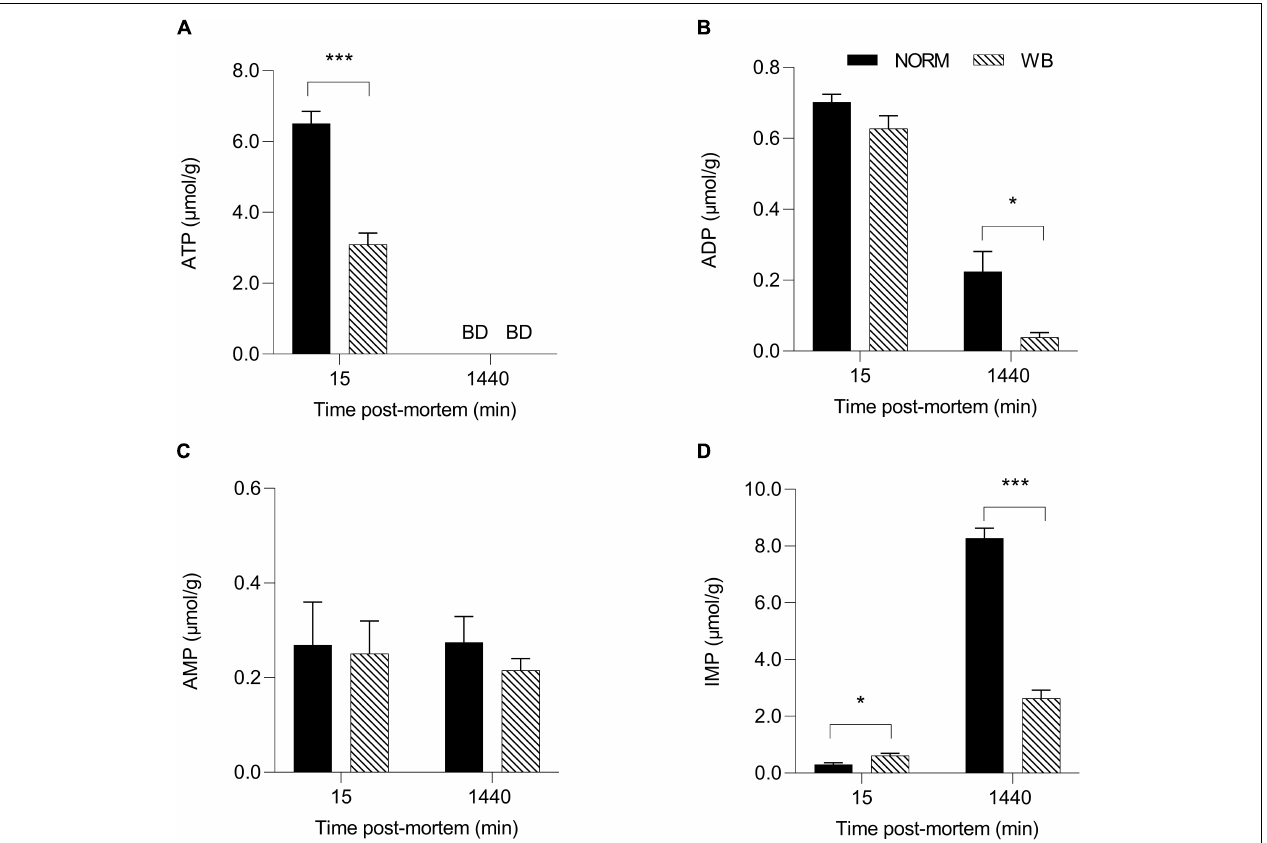
FIGURE 6 | Average ATP ( A , µ mol/g), ADP ( B , µ mol/g), AMP ( C , µ mol/g), and IMP ( D , µ mol/g) of unaffected (NORM) and wooden breast (WB) broiler pectoralis major muscles ( n = 12/group) at 15 and 1,440 min post-mortem. Data represent means ± SEM. Asterisks indicate a significant difference within the time point (*** P < 0.001; * P < 0.05). BD, below limit of